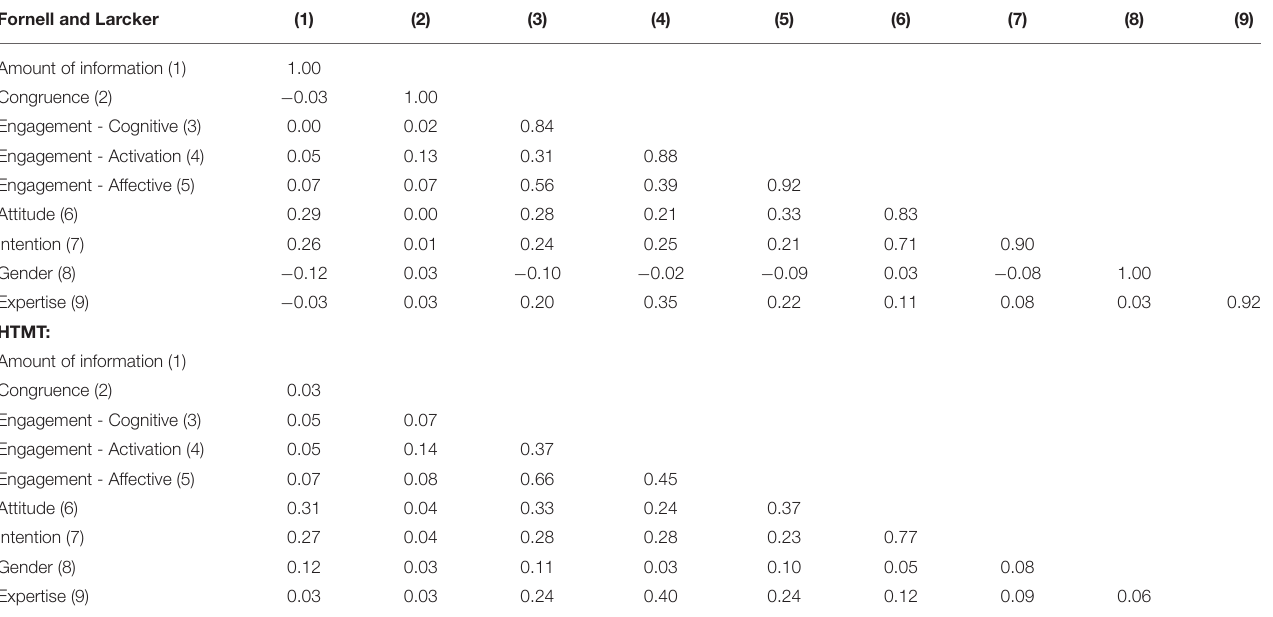
TABLE 3 | Discriminant validity